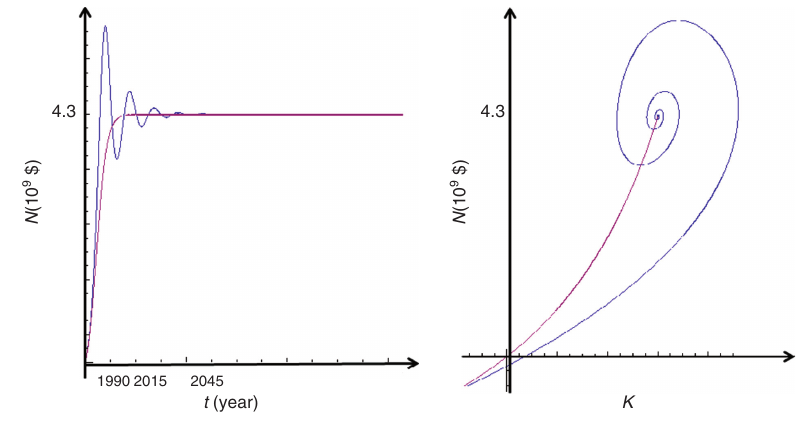
Figure 3 Time delay τ = 2.2